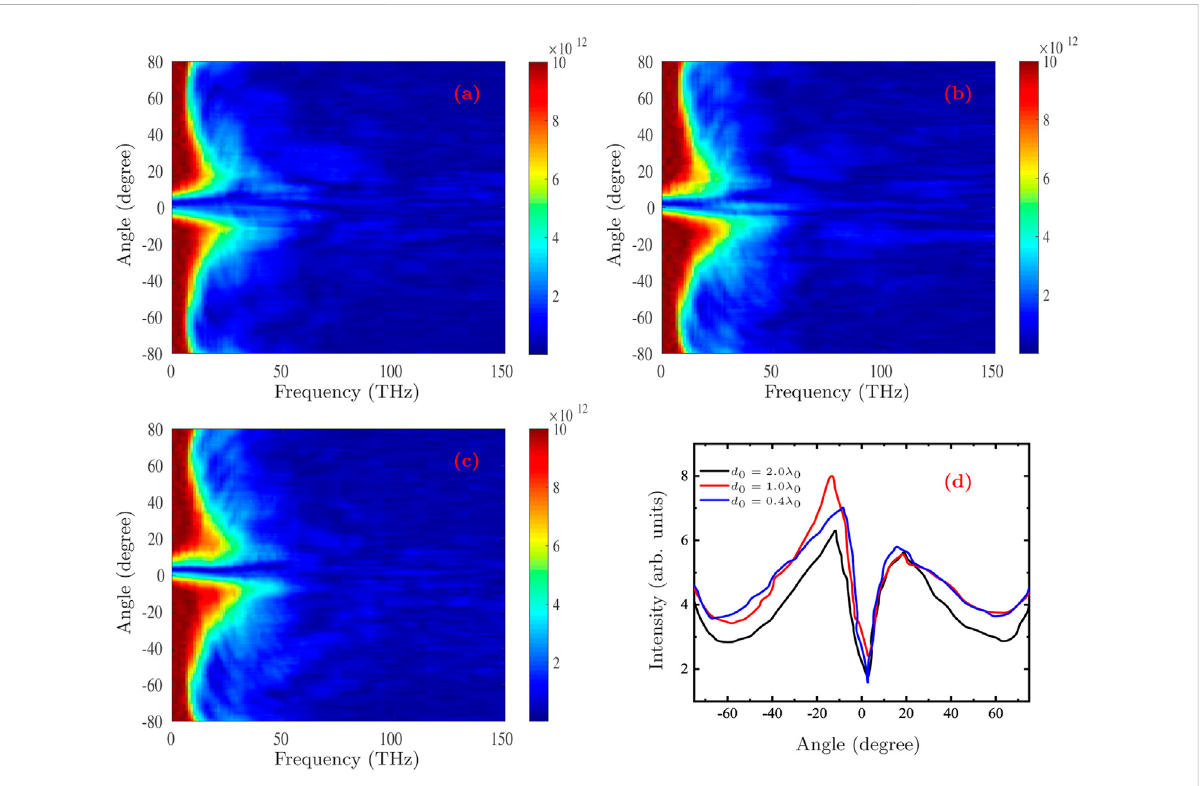
FIGURE 8 Theangular-spectra distribution oftheTHzradiationfor differentthicknessoftheTarget-Iwith d 0 =2.0 λ 0 (A) , d 0 =1.0 λ 0 (B) ,and d 0 =0.4 λ 0 (C) . (D) The corresponding cumulatively summed angular-spectra distribution of THz